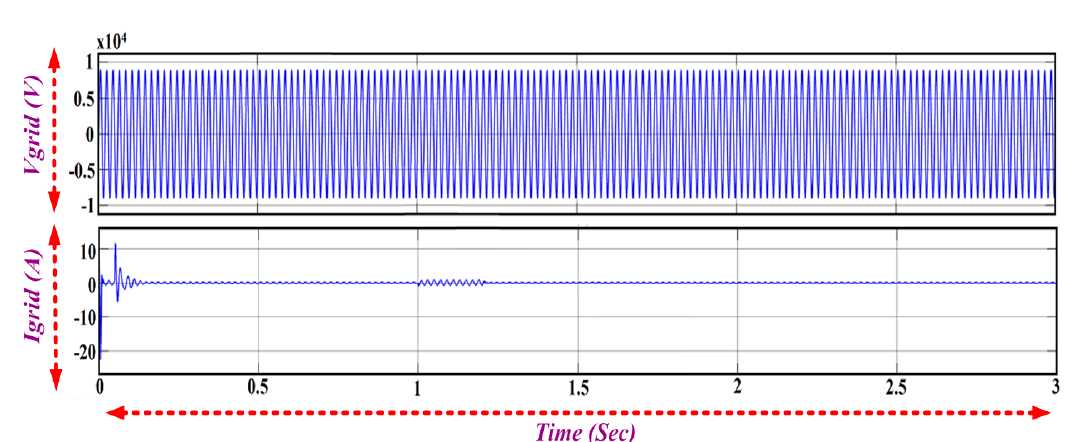
Figure 18. Grid Voltage (Vgrid) and Grid Current (Igrid).